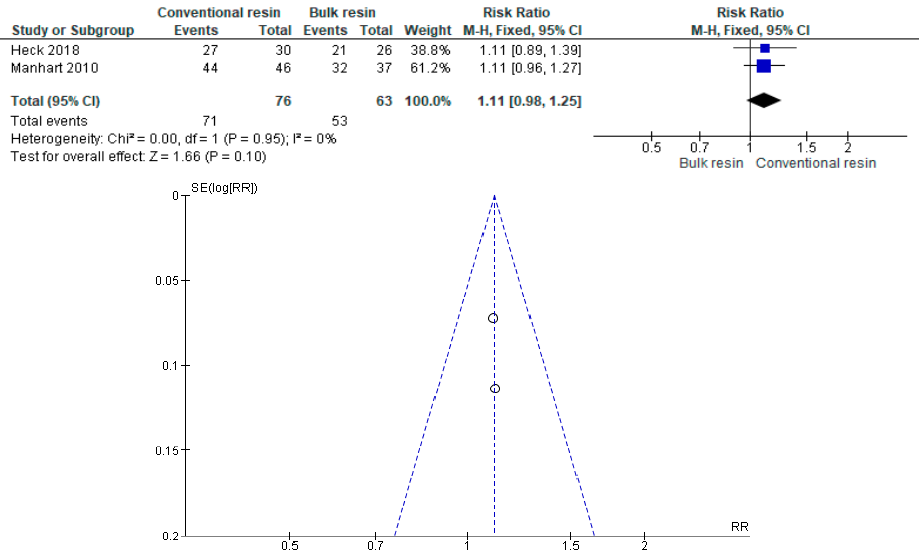
Figure A41. Adequate Tooth Integrity: Conventional Resin versus Bulk Resin.